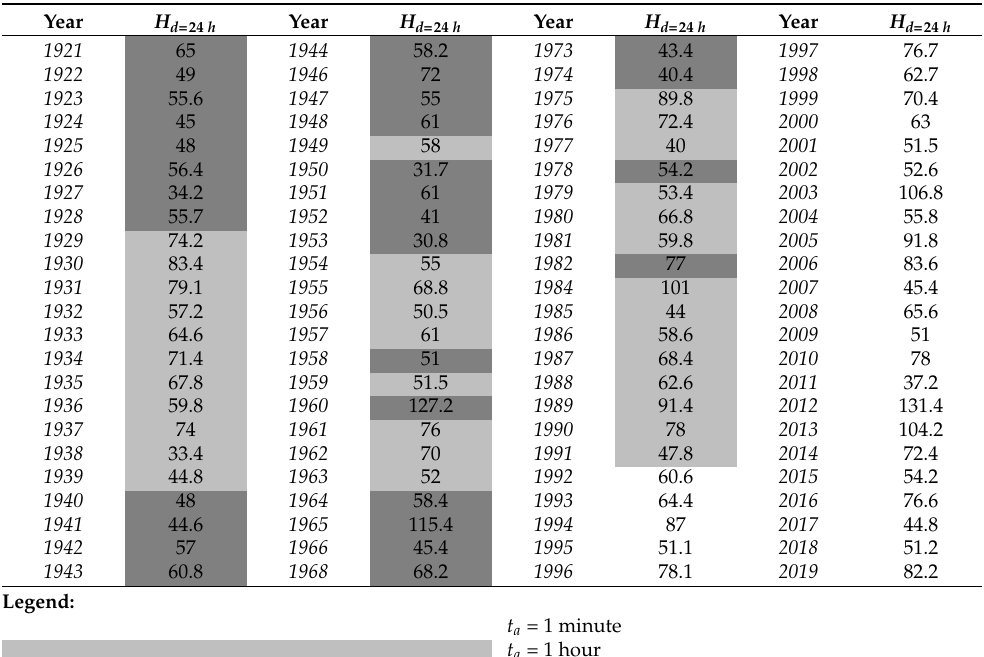
Table 2. Annual maximum rainfall depths (in mm) for duration ( d ) equal to 24 h, H d= 24 h , derived from data characterized by different aggregation times, t a . Gubbio rain gauge station.